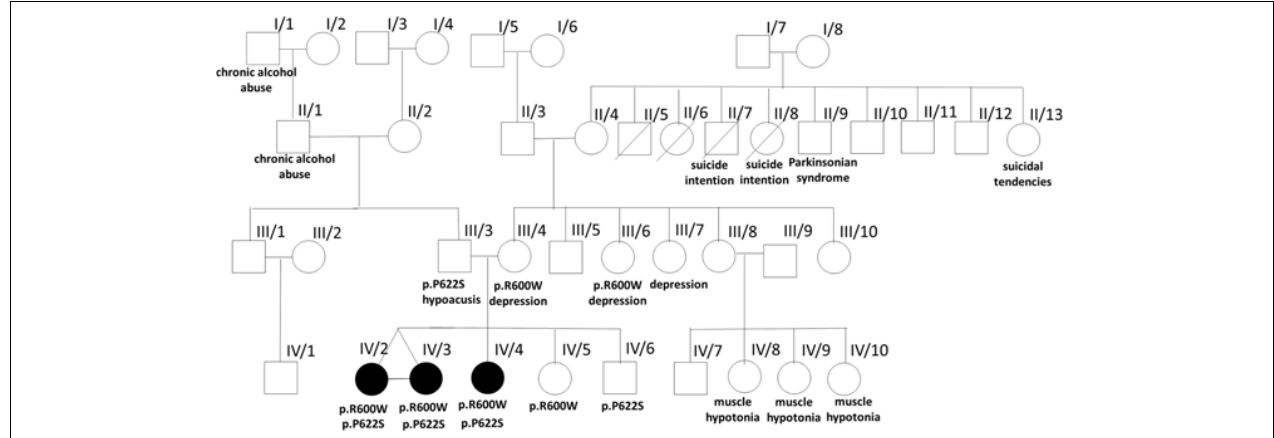
FIGURE 1 | Pedigree of the affected family. The pedigree of the investigated family is presented with some clinical data from the family history and the results of the identified two PLA2G6 gene mutations.